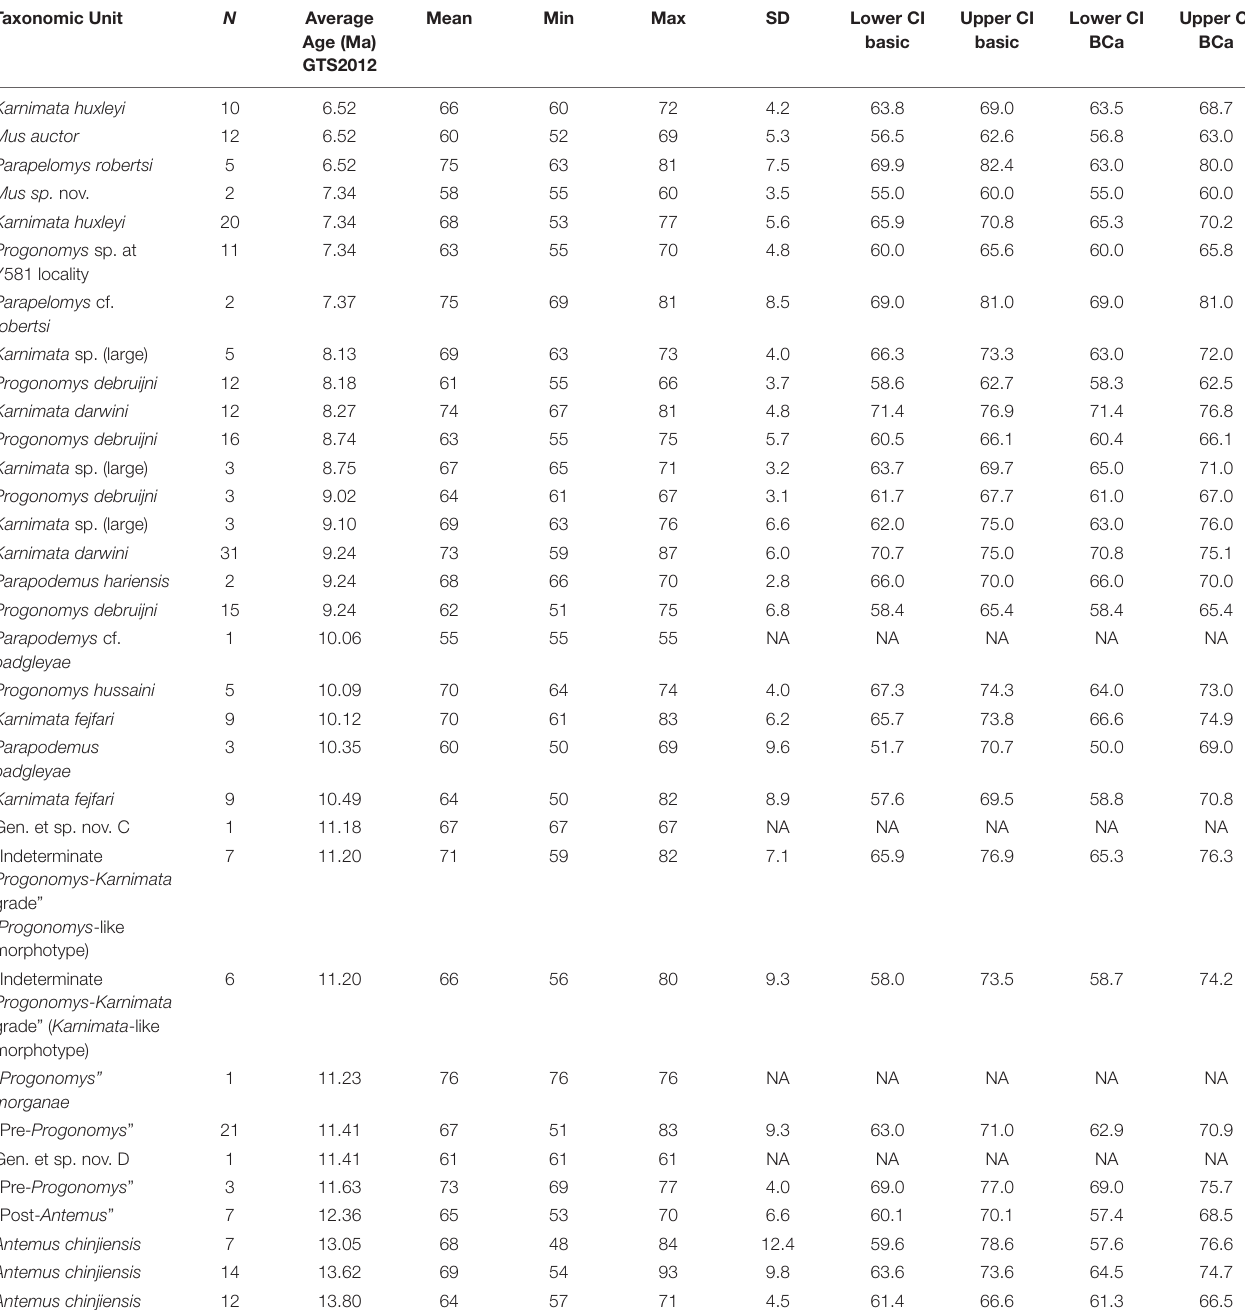
TABLE 4 | Summary statistics for angle formed by the protocone and enterostyle in Siwalik murine rodents, corresponding to Figure 3C . Taxonomic Unit N Average